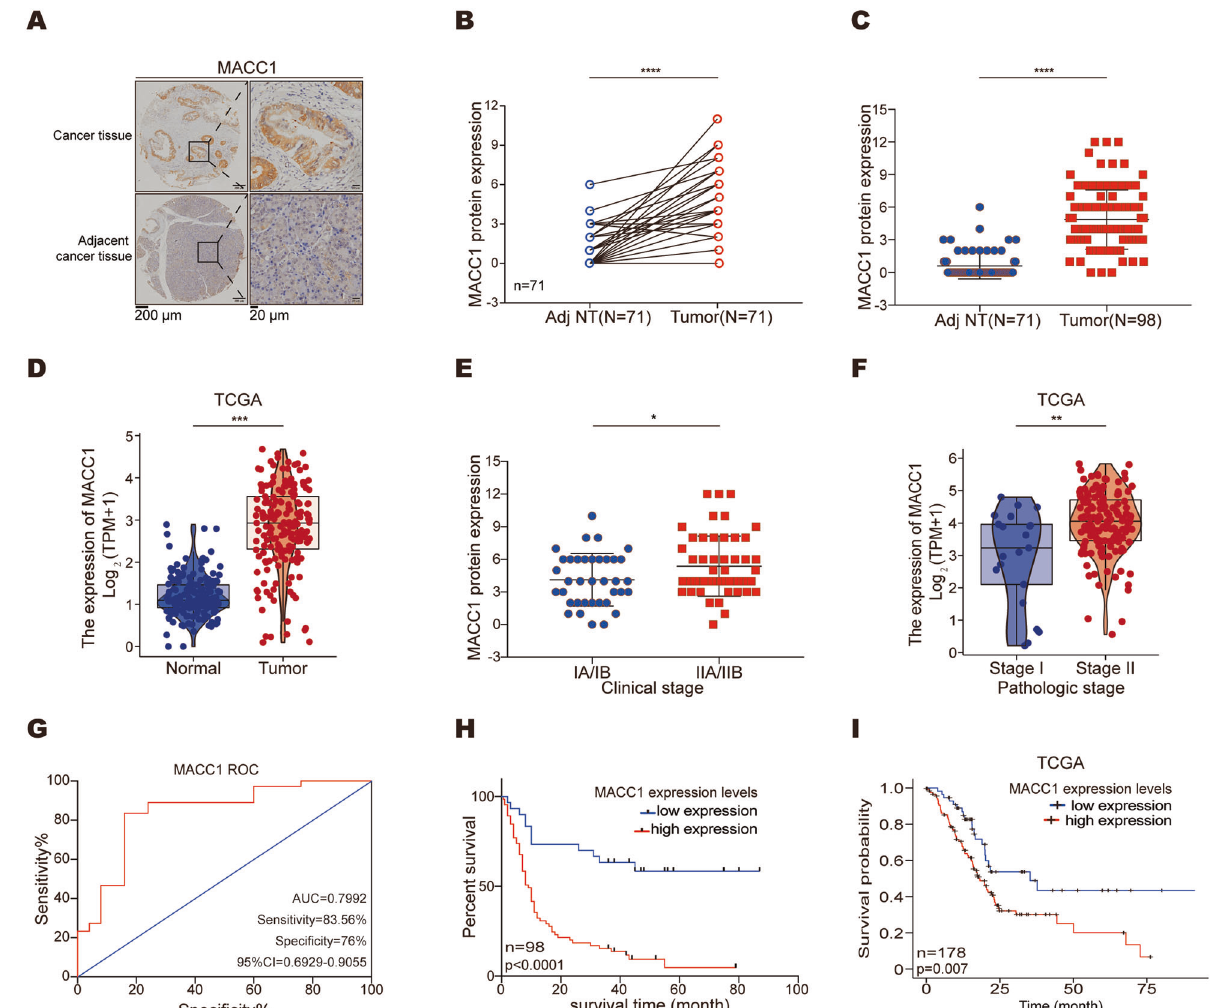
Fig. 1 MACC1 expression is upregulated in PC tissues and correlates with poor outcomes in PC patients. A Representative images of immunohistochemistry for MACC1 expression levels in PC TMAs. Scale bar, left, 200 μ m; right, 20 μ m. B Comparison of MACC1 staining score in paired PC (tumor, n = 71) and the corresponding adjacent noncancerous tissues (Adj NT, n = 71). Two-tailed t test. **** p < 0.0001. C Comparison of MACC1 staining scores in unpaired PC (tumor, n = 98) and adjacent noncancerous tissues (Adj NT, n = 71). Two-tailed t test. **** p < 0.0001. D MACC1 expression in TCGA PC and normal tissues. Two-tailed t test. *** p < 0.001. E MACC1 protein expression levels in PC samples grouped by clinical stage. Two-tailed t test. * p < 0.05. F MACC1 mRNA expression levels in PC samples grouped by pathological stage (data retrieved from the TCGA database). Mann – Whitney test. ** p < 0.01. G ROC analysis to evaluate the predictive value of MACC1 levels for patient survival time. H Kaplan – Meier curve for overall survival by MACC1 protein levels. I Survival plot in TCGA PC patients according to MACC1 mRNA expression (containing 71 pairs of primary tumor tissues and the correspond- ing adjacent noncancerous tissues). Our results showed that MACC1 protein was abundant in PC tissues (Fig. 1A) and was highly expressed in both paired (Fig. 1B) and unpaired cancer tissues (Fig. 1C) when compared to noncancerous tissues. We further compared MACC1 expression between normal and PC tissues in The Cancer Genome Atlas (TCGA). As expected, the TCGA data showed that MACC1 was highly expressed in PC tissues compared to normal tissues (Fig. 1D) and was upregulated in multiple human tumor types (Fig. S1A). Next, we investigated the clinical implications of MACC1 via analysis of the relationship between clinicopathological characteristics and MACC1 levels in the TMA and TCGA. We discovered that MACC1 was closely associated with the pathological stage (including pathological stage and advanced T classi fi cation) and clinical stage (including clinical stage and distant metastasis) of PC patients (Fig. 1E, F and Fig. S1B, C). In addition, the ROC examination indicated that